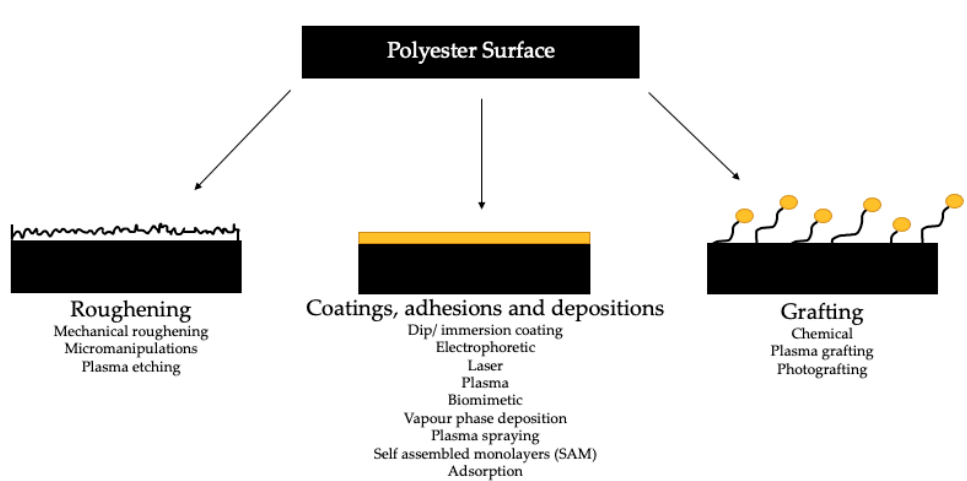
Figure 2. Polymer surface modification methods (for biodegradable polymers) [89,91,98–101].